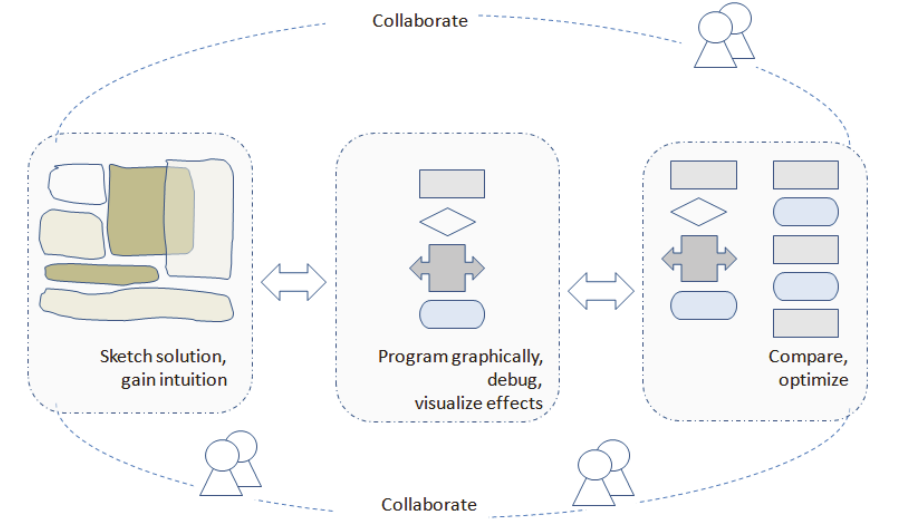
Figure 1. A game-based learning framework for building analytical thinking skills through experimentation, solution structuring, and optimization.